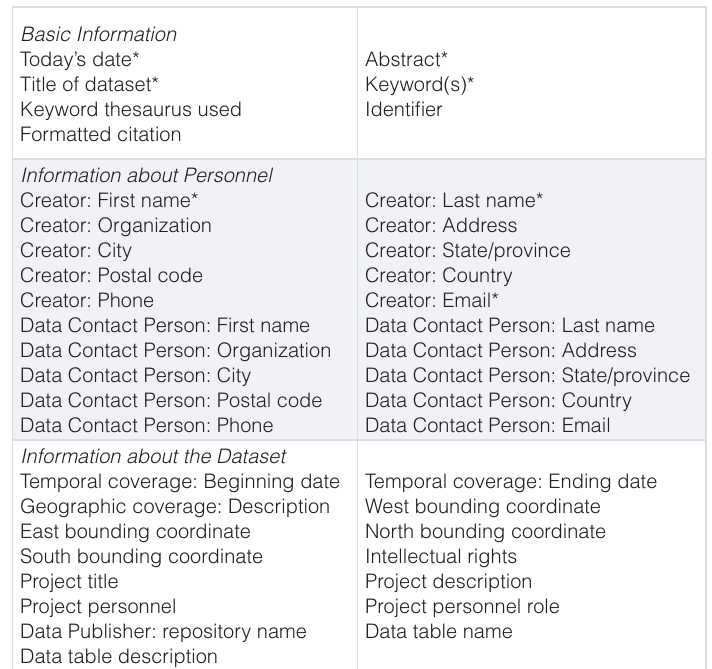
Table 3. Metadata elements chosen for the DataUp metadata schema. *elements are